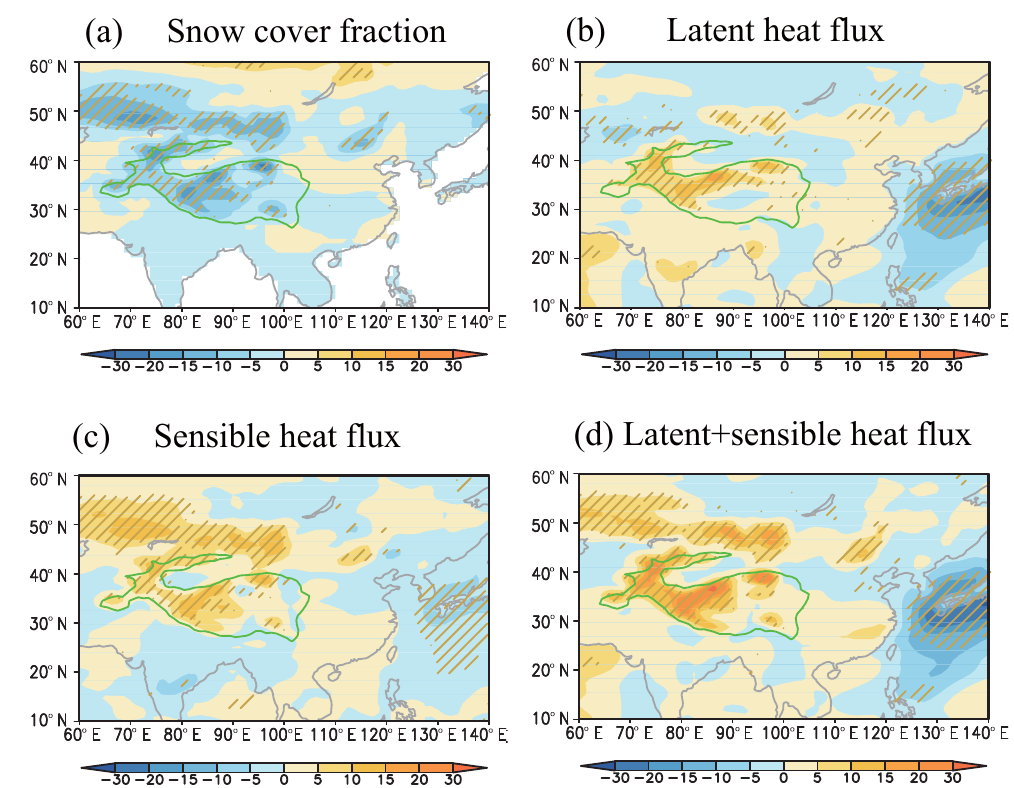
Figure 8. Spatial distribution of the changes in (a) the snow cover fraction (%), (b) the surface latent heat flux (Wm − 2 ), (c) the surface sensible heat flux (Wm − 2 ) and (d) the surface latent + sensible heat flux (Wm − 2 ) in MAM induced by the dust-in-snow radiative forcing. Here the slanted lines in the grey shaded area represent the grid points where the changes pass the two-tailed t test at the 5% significance level. The green outlined area indicates the plateau above 2500m.